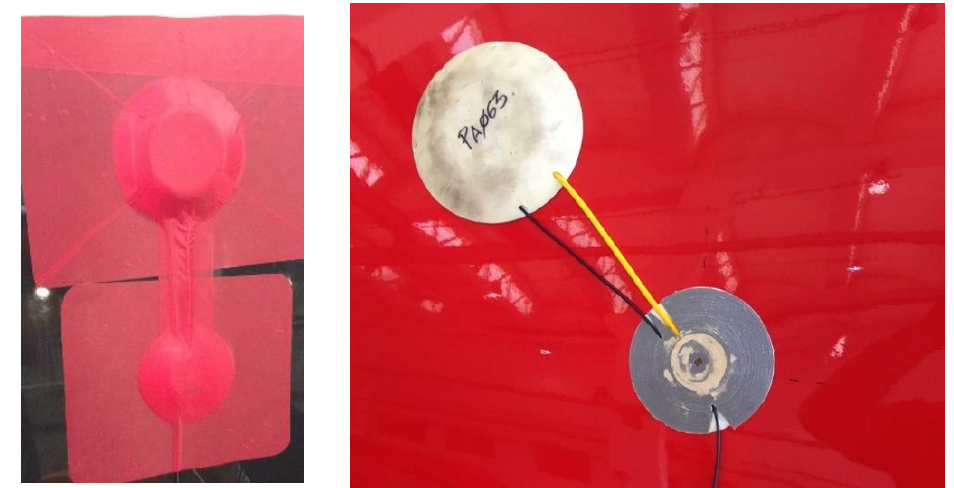
Figure 9. Two views of the fairings covering the pressure tap and the sensor with and without the adhesive tissue. adhesive tissue.